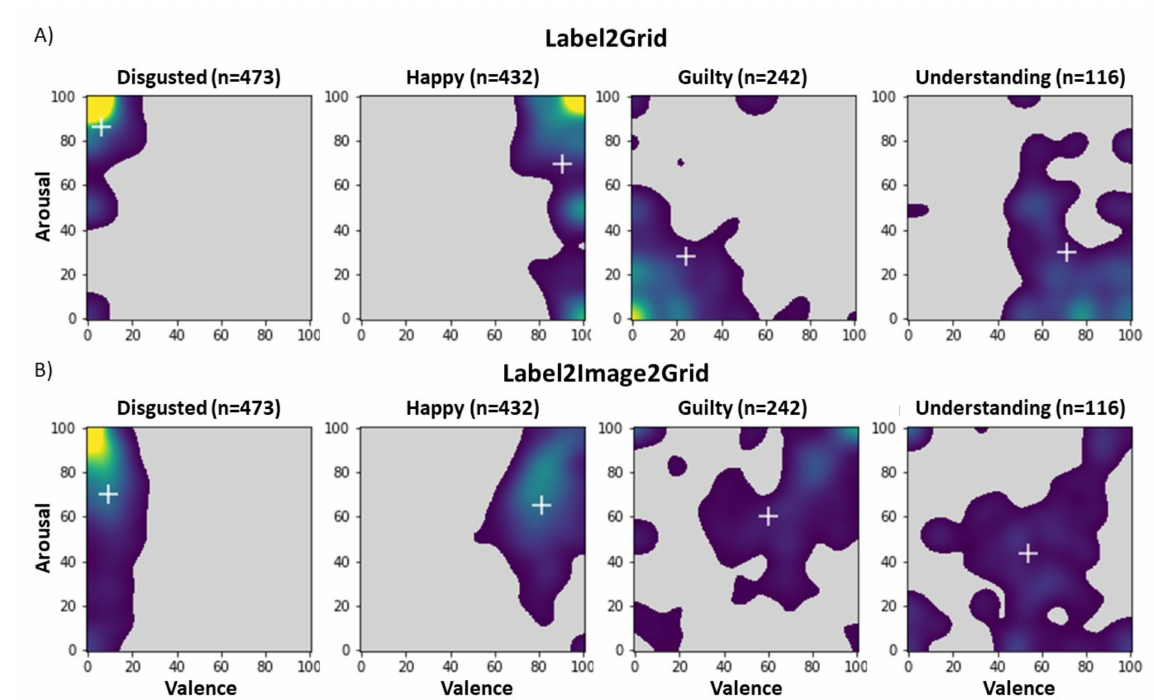
Figure 11. Distribution of the mapping responses over the valence–arousal space, for four differ- ent words (disgusted, happy, guilty, and understanding). ( A ) Distribution of the direct mapping responses, when participants were asked to map a word directly to the EmojiGrid ( Label2Grid ). ( B ) Distribution of the indirect ( Label2Image2Grid ) term-to-EmojiGrid mapping responses, when par- ticipants first linked a term to an image ( Label2Image task) and then rated the image in terms of valence and arousal ( Image2Grid task). Crosses signify group mean arousal and valence